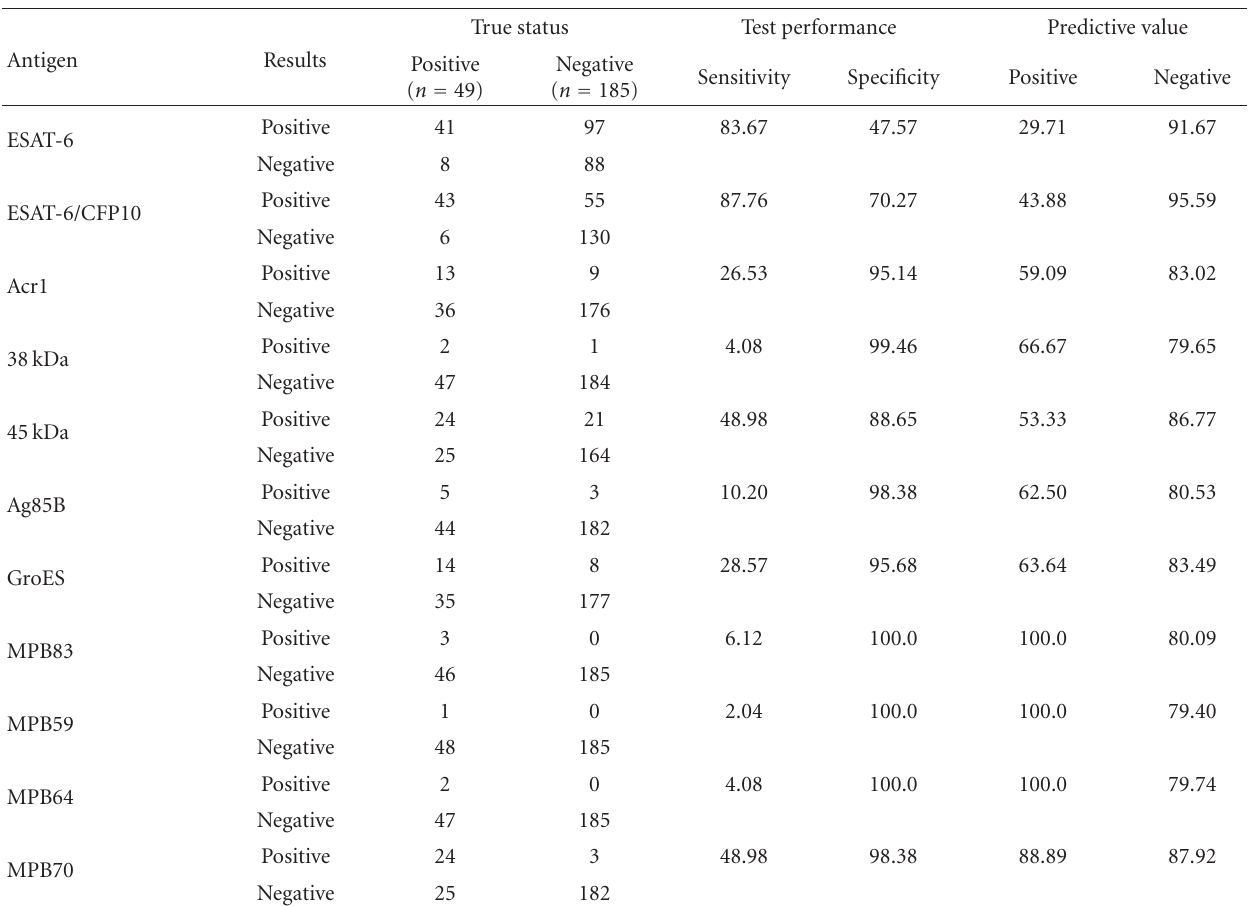
Table 3: Sensitivity, specificity, positive predictive value, and negative predictive value of weak or strong positive reactions to individual antigens used in MAPIA.